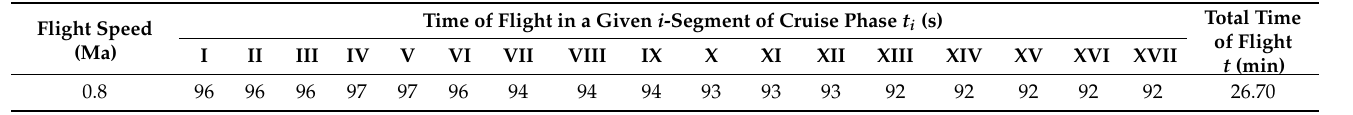
Table 3. Flight duration in cruising phase of the aircraft travelling with the speed of 0.8 Ma at the altitude of 10 km in meteorological conditions on 6 April 2020. Flight Speed